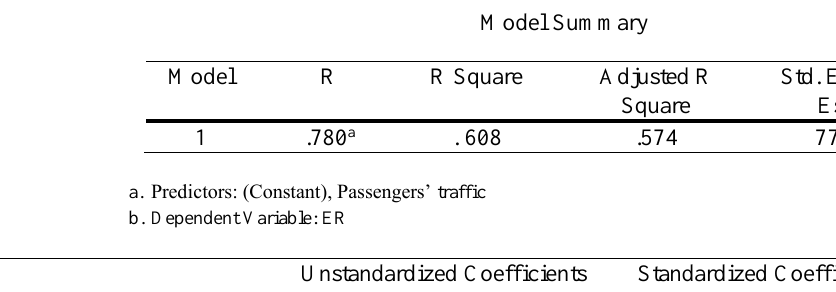
Table 2. Effect of passengers’ traffic on